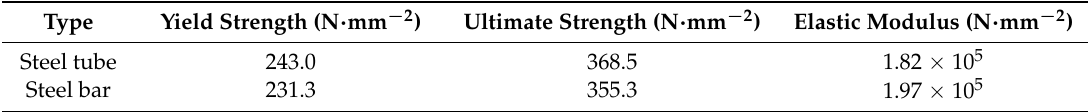
Table 3. Properties of concrete.